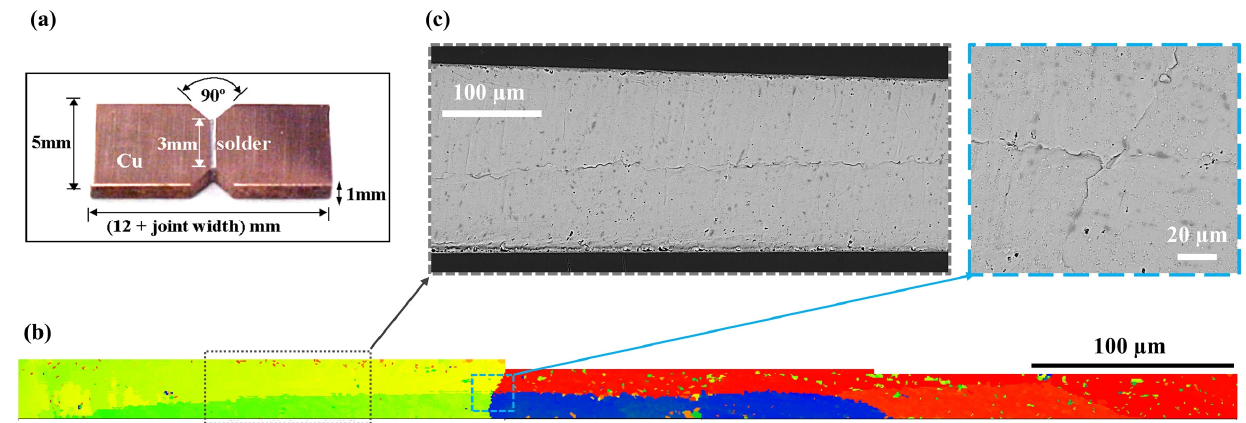
Figure 1. Sample 1 used in the TMM shear test: ( a ) nominal dimensions of modified Iosipescu shear specimens, ( b ) EBSD scanning of the solder joint of Sample 1, ( c ) ESEM images of failure patterns along the grain boundary after creep test.